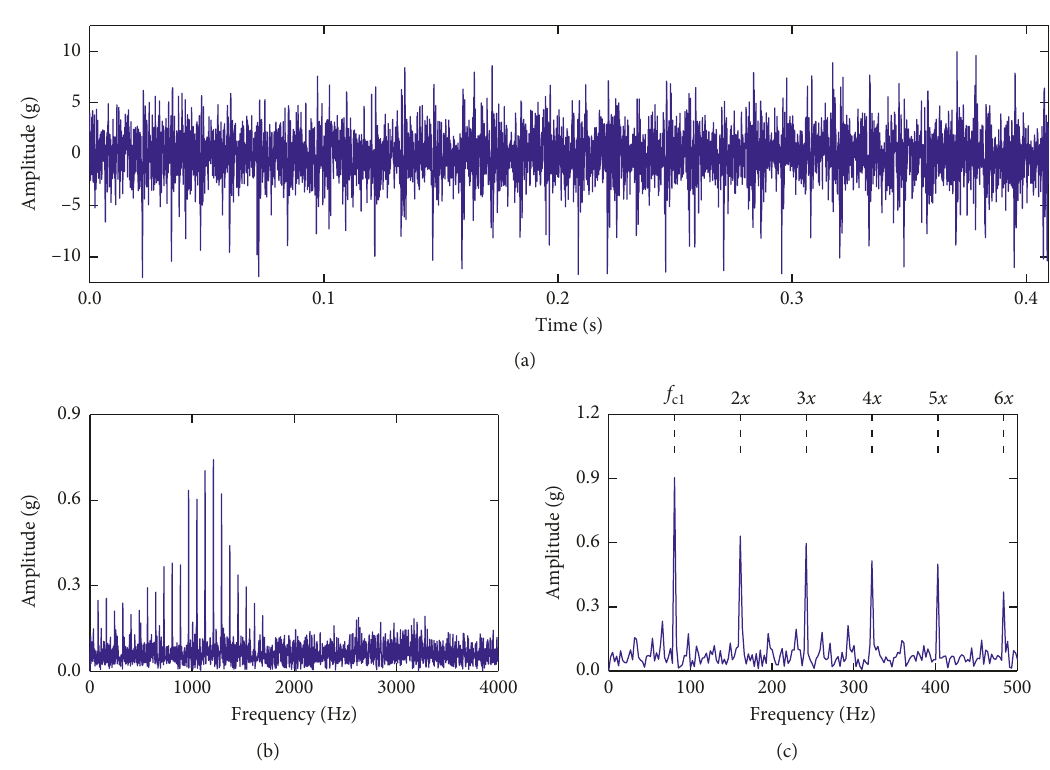
Figure 5: Simulation signal with a SNR of − 3dB: (a) time-domain waveform; (b) Fourier spectrum of (a); (c) Hilbert envelope spectrum of